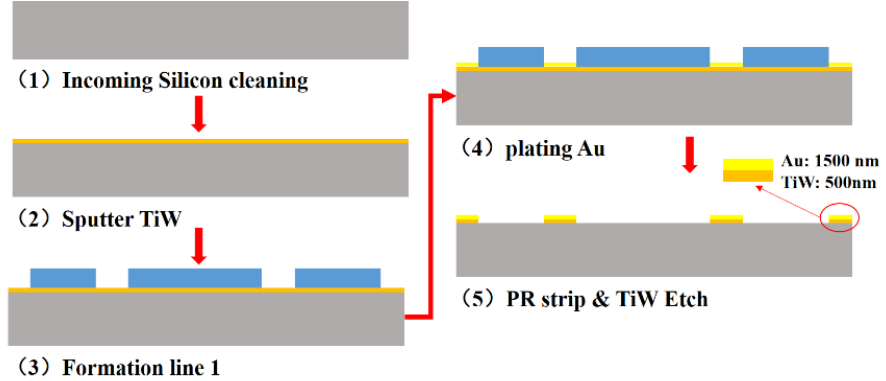
Figure 5. Dummy device wafer fabrication process flow.